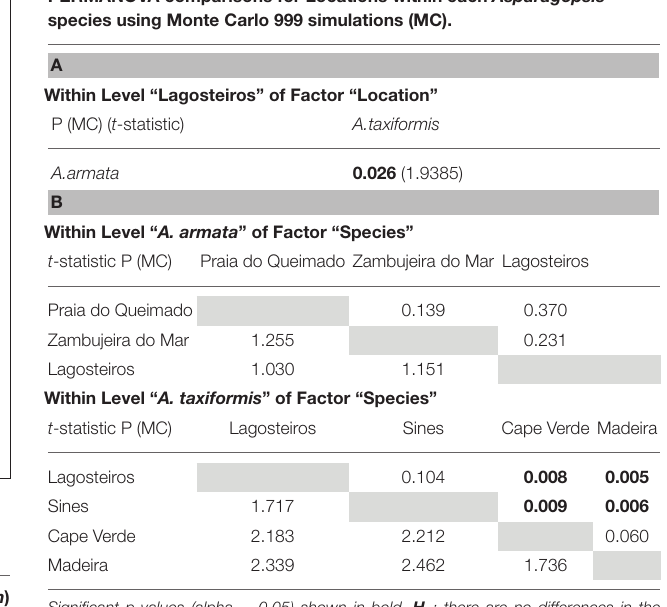
Significant p-values (alpha = 0.05) shown in bold. H 0 : there are no differences in the distribution of OTUs in the different levels of the different factors, H 0 rejected if: p < 0.05. Bold face values are significant at P < 0.05. TABLE 4 | Statistical results of One-way ANOSIM with Bray-Curtis distance measures applied to each Asparagopsis group of species using OTU hits (Based on 9999 permutations).